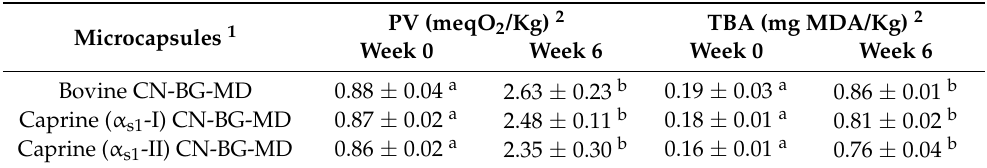
Table 5. Formation of hydroperoxides and MDA from lutein microcapsules at week 0 and week 6 (at 40 ◦ C and 32% relative